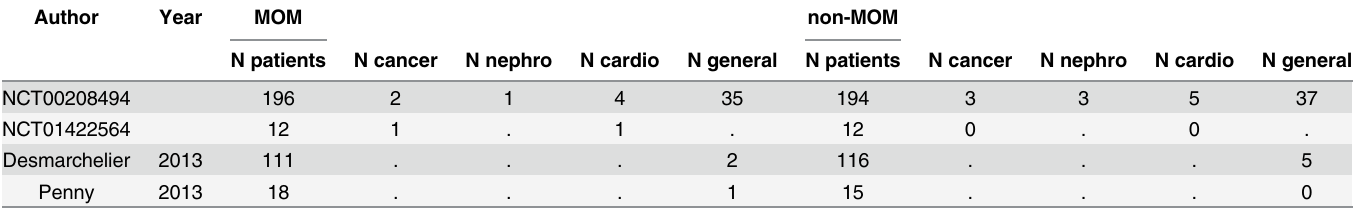
Table 3. Medical complications for RCTs.